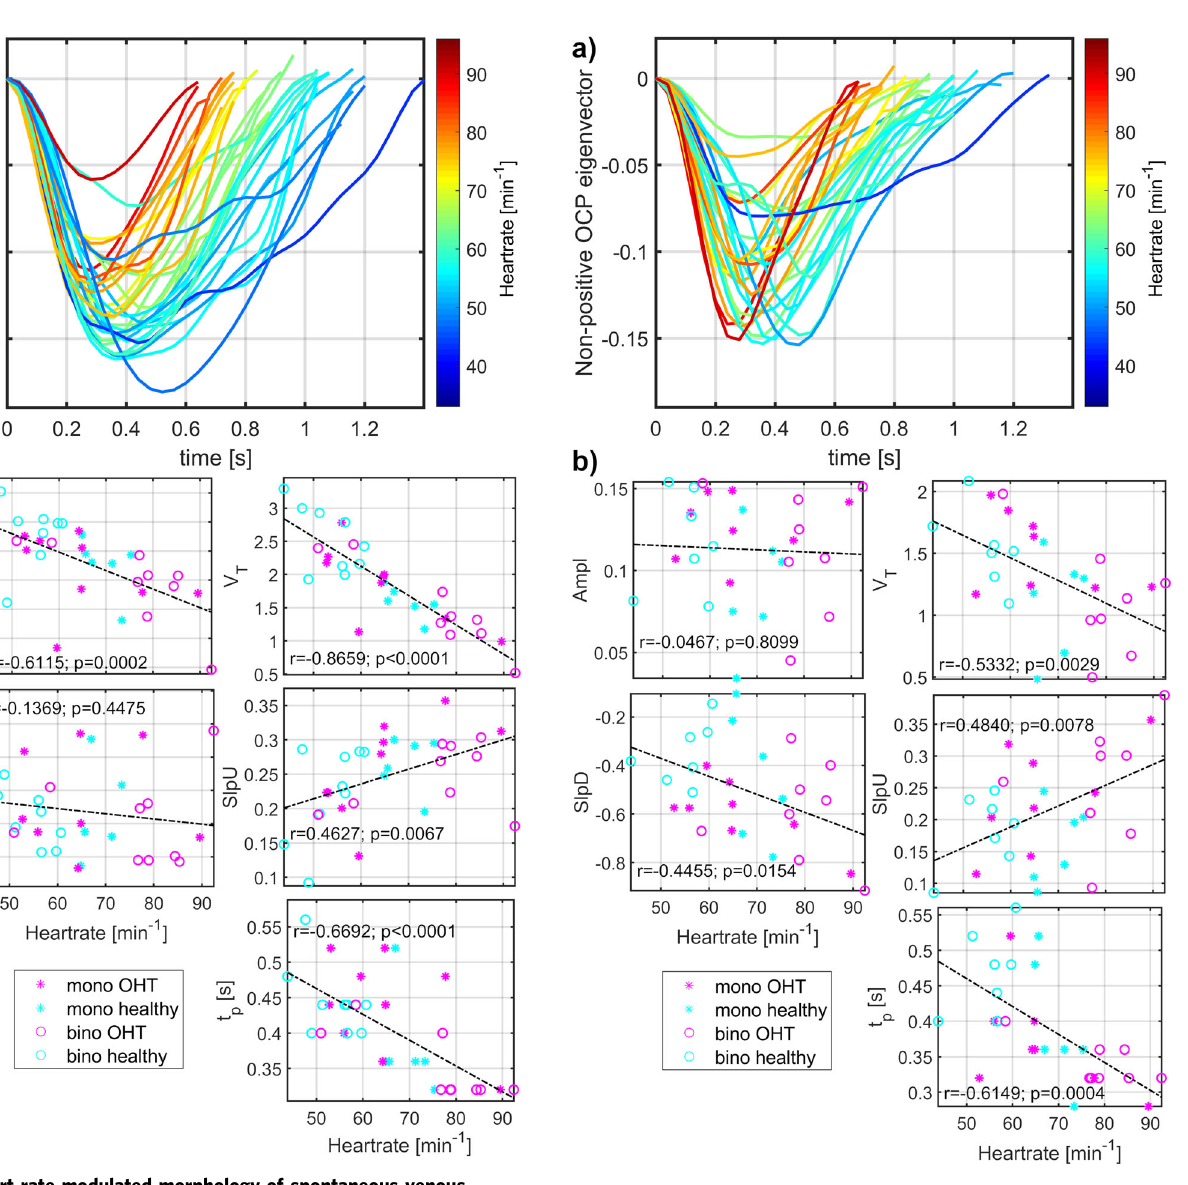
Fig. 3 Heart rate modulated morphology of optic cup pulsations (OCP). a Visualization of mean single-pulses over all monocular (mono) and binocular (bino) retinal video-recordings from healthy controls and patients with medicated ocular hypertension (OHT). Graph lines are heart rate color-coded. b Evaluation of linear dependence between heart rate and OCP morphology measurements (Ampl amplitude of the OCP eigenvector, V T total relative pulse stroke volume in the eigenvector measures, SlpD slope- down from the eigenvector value at the period beginning to the negative eigenvector peak ≈ peak of the maximal absolute blood volume time-point, SlpU slope-up from the negative eigenvector peak to the period end, t p time to the negative eigenvector peak). Value r represents a corresponding Pearson correlation coef fi cient and value p the p -value of the correlation